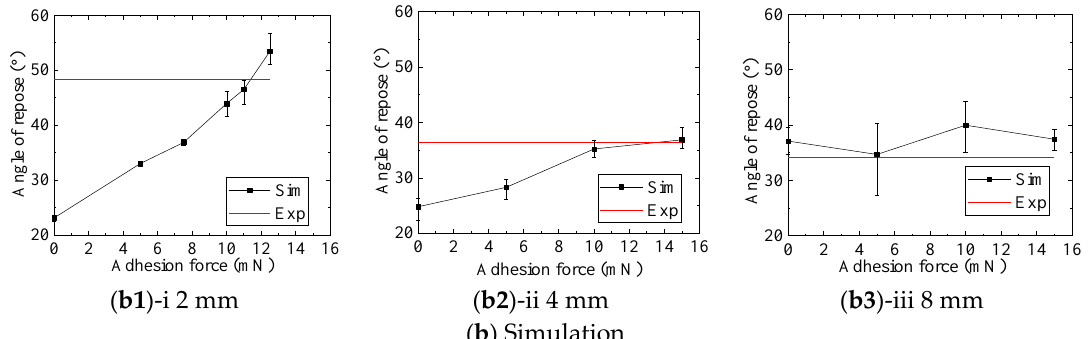
Figure 2. Snapshots of the angle of repose test results: ( a ) experiment, ( b ) simulation.